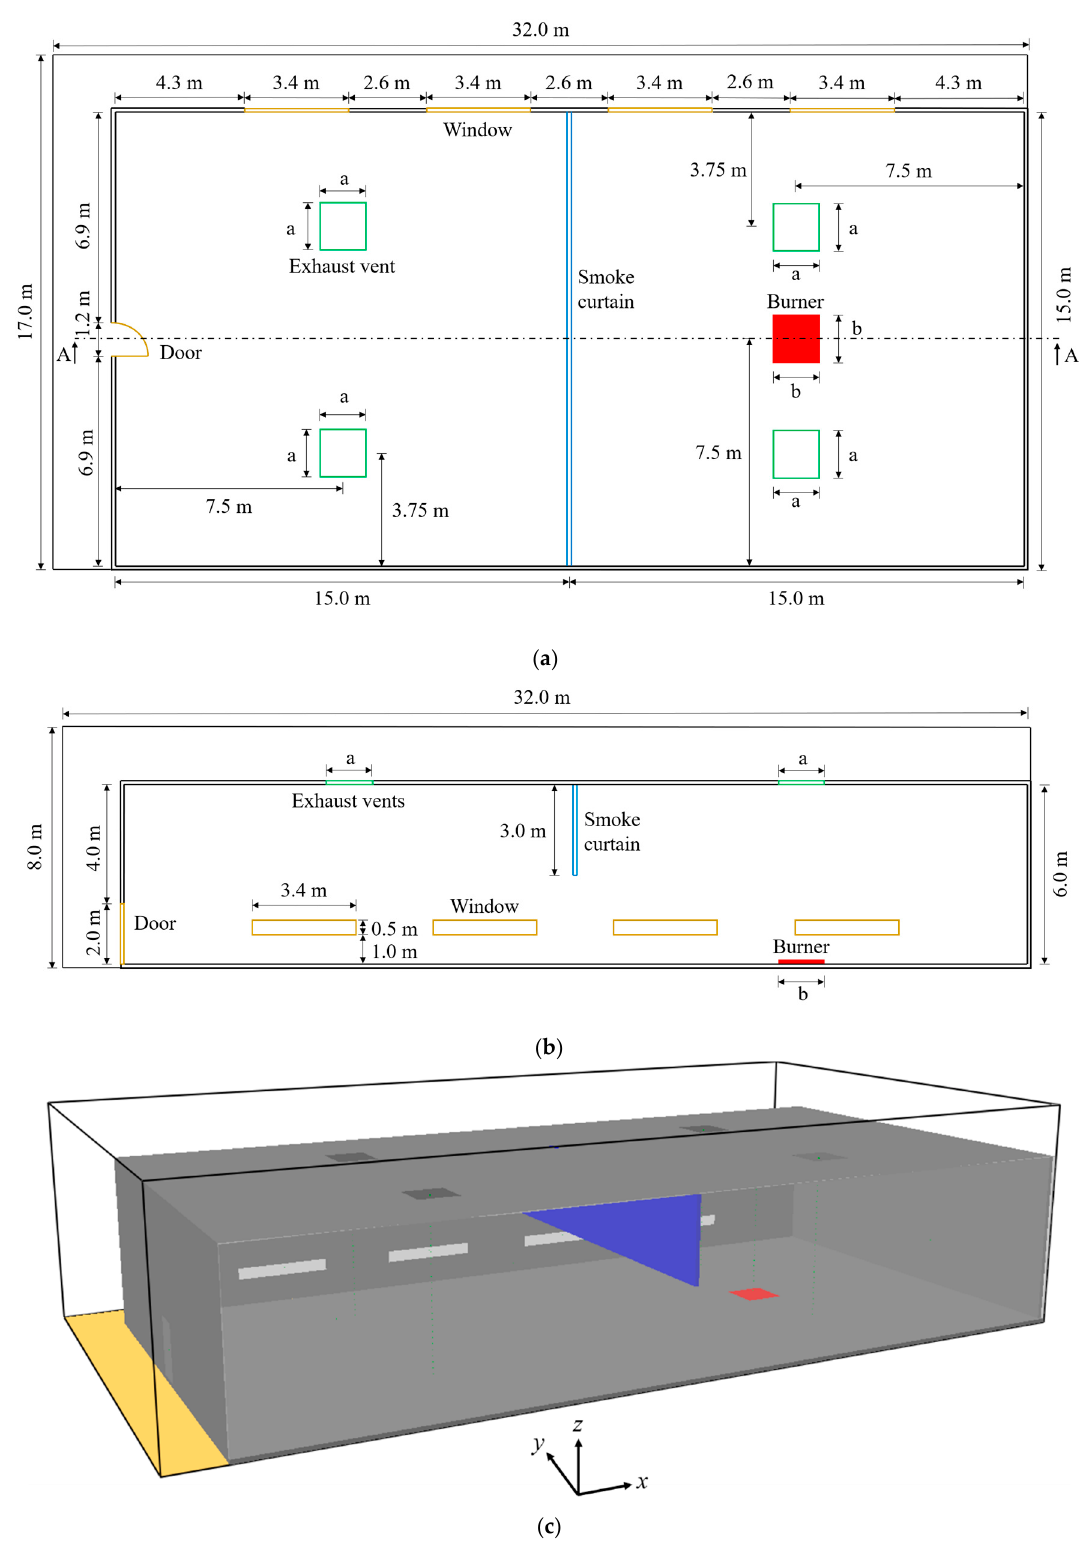
Figure 1. Physical domain under study ( a ) top view, ( b ) section A-A and ( c ) isometric view with transparent front wall.